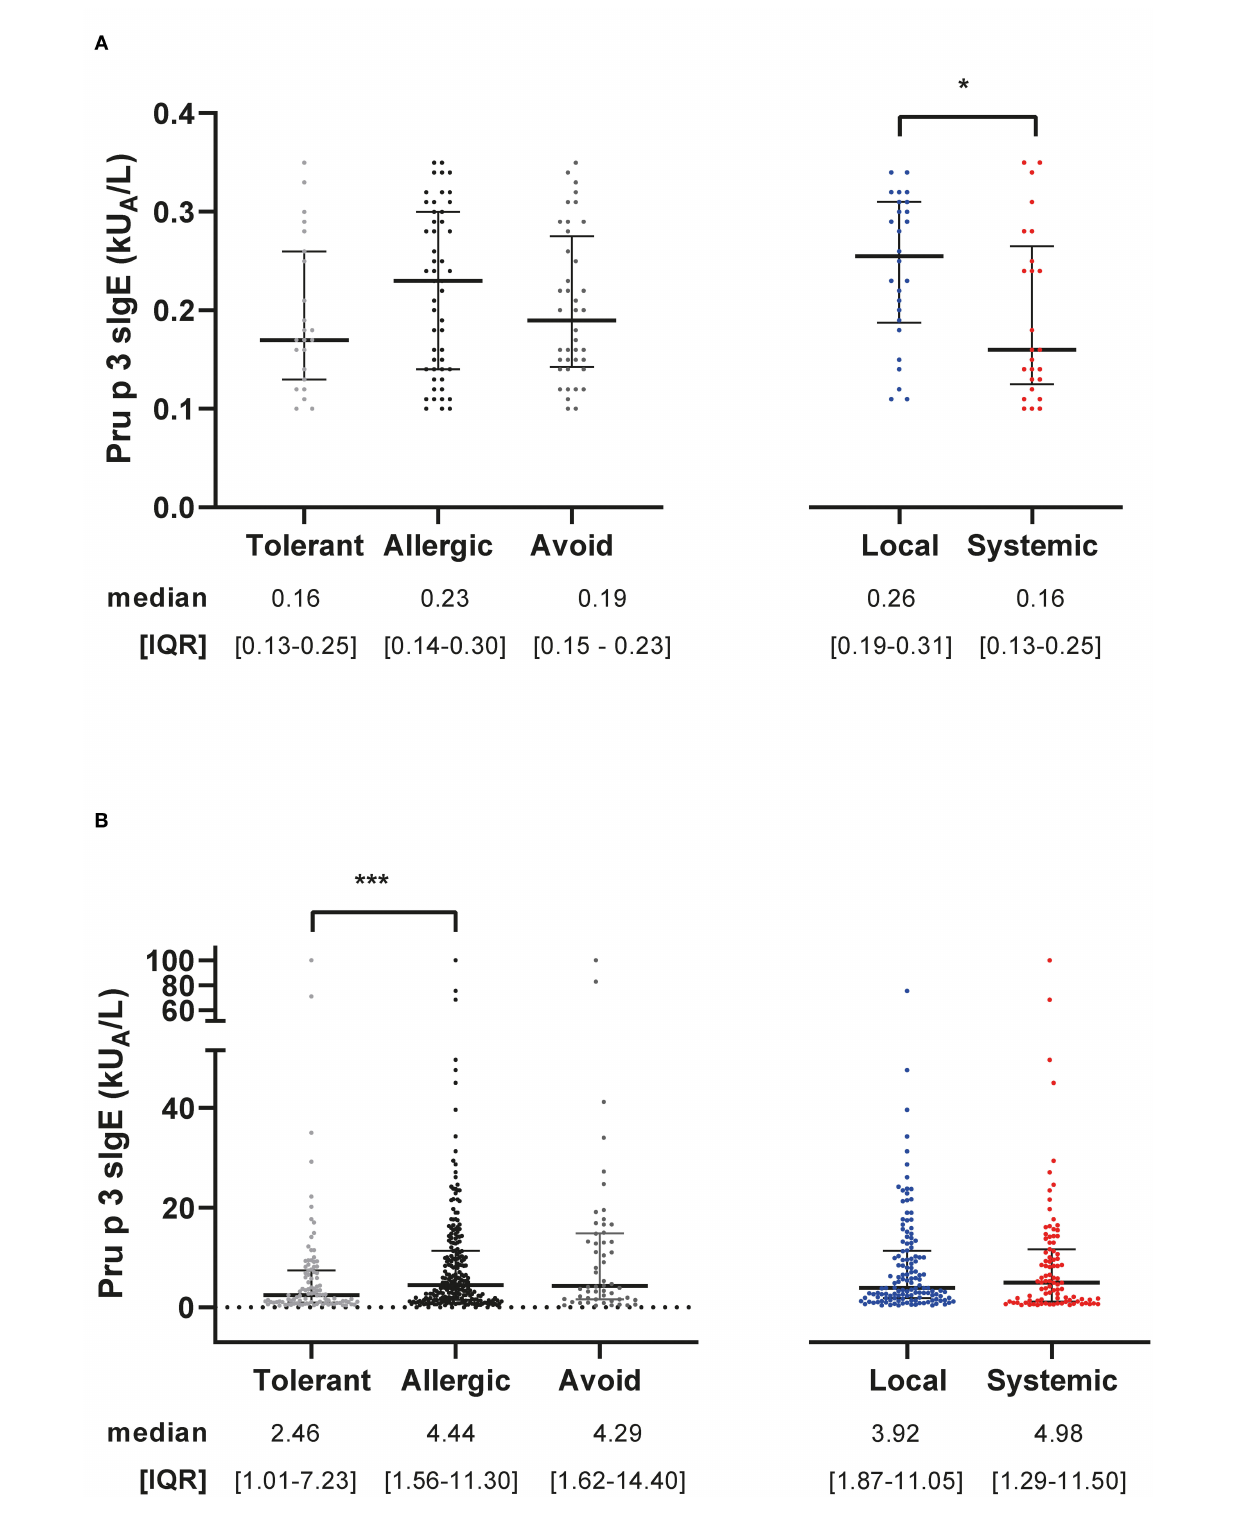
FIGURE 1 | Levels of Pru p 3 sIgE per group. Pru p 3 sIgE distribution, median, and IQR (interquartile range) values from grLOW (A) and grB (B) according to symptom classification (tolerance vs. allergy, local vs. systemic). The Mann–Whitney test was used to test p (*0.01 to 0.05, ***0.0001 to 0.001).